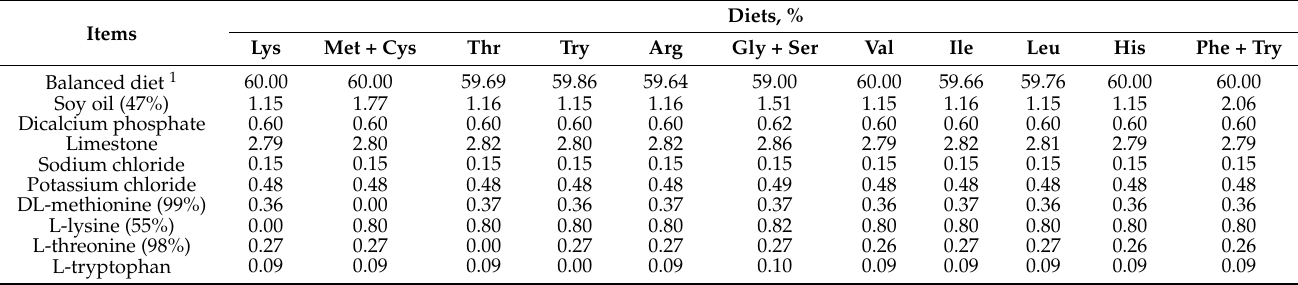
Table 4. Composition of the diet for all tested amino